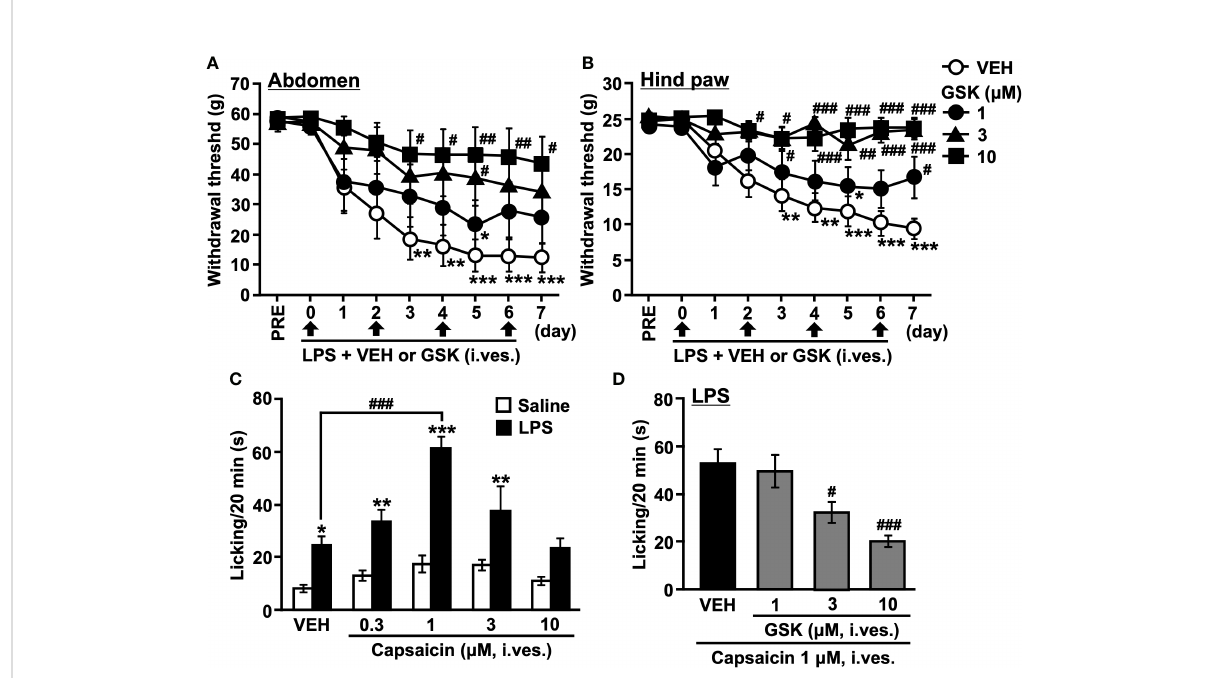
FIGURE 2 Repeated intravesical (i. ves.) instillation of GSK prevented the development of hypersensitivity to LPS-induced cystitis in rats. The von Frey fi laments were applied to (A) the abdominal area close to the urinary bladder and (B) the plantar surface of the hind paw. The mechanical withdrawal threshold is presented over time. (C) Total time spent licking behavior evoked by (i) ves. instillation of capsaicin during the 20 min of the test on saline- and LPS-treated groups. (D) Total time spent licking behavior evoked by (i) ves. instillation of capsaicin during the 20 min